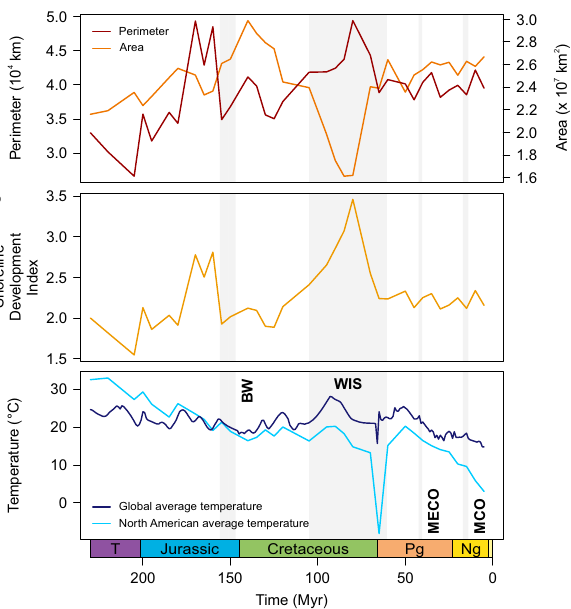
Figure 3. Abiotic factors used in this study. ( a ) Continental area and perimeter, ( b ) the resulting Shoreline Development Index (SDI), as well as ( c ) regional and global average temperature through geological time. Time intervals with major seas/wetlands and climatic events referred to in the text are marked by gray bars. Note that the last time bin (0–5 Myr ago) was omitted; see Methods for details. BW, Bighorn wetlands; MECO, Middle Eocene Climate Optimum; MCO, Miocene Climate Optimum; WIS, Western Interior